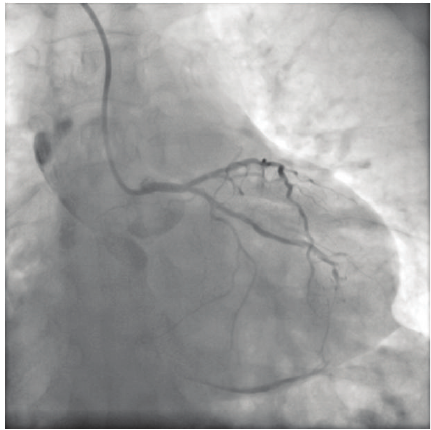
Figure 6: Coronary AV fistula (OM1 to coronary